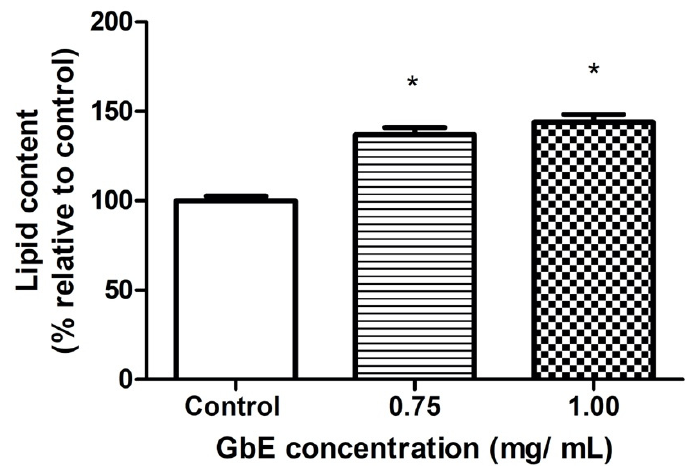
Figure 2. Representative confocal microscopy images (128× magnification) of 3T3 ‐ L1 cells after 7 days of differentiation stained with Oil Red O. ( A ) Control; GbE ‐ treated at concentrations: ( B ) 0.75 mg/mL and ( C ) 1.00 mg/mL. Blank arrows represent lipids located inside adipocytes.